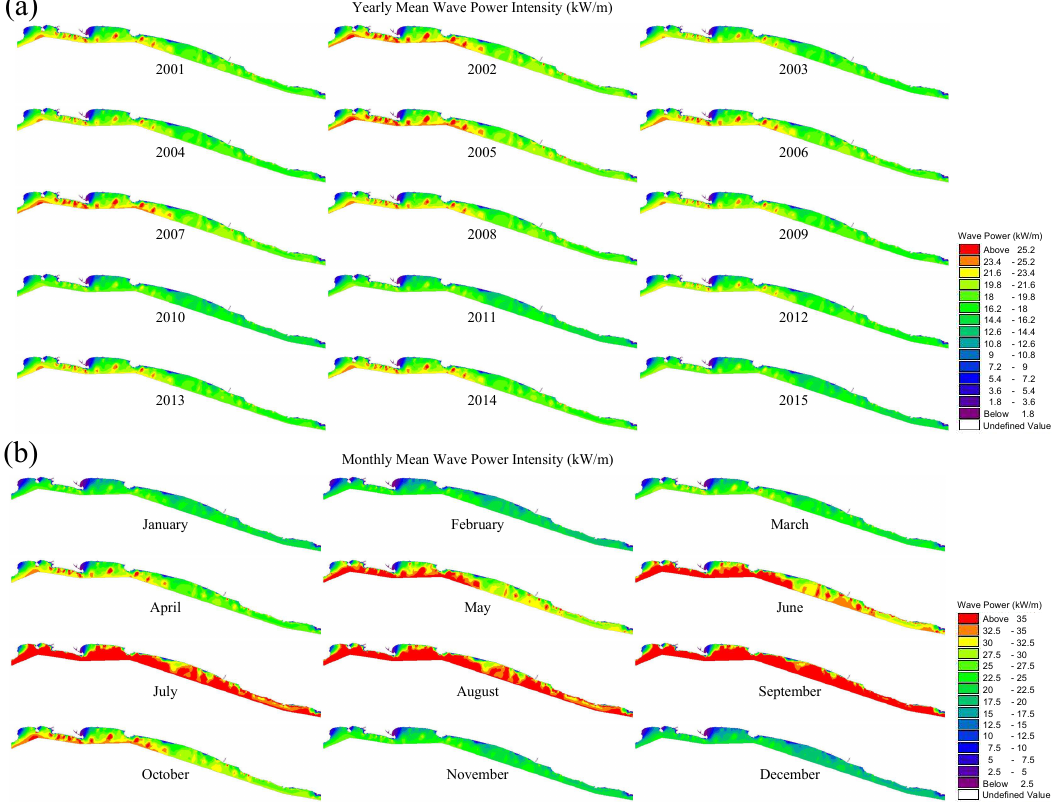
Figure 4. Set of contours for the yearly ( a ) and monthly ( b ) mean wave power intensity (kW/m).